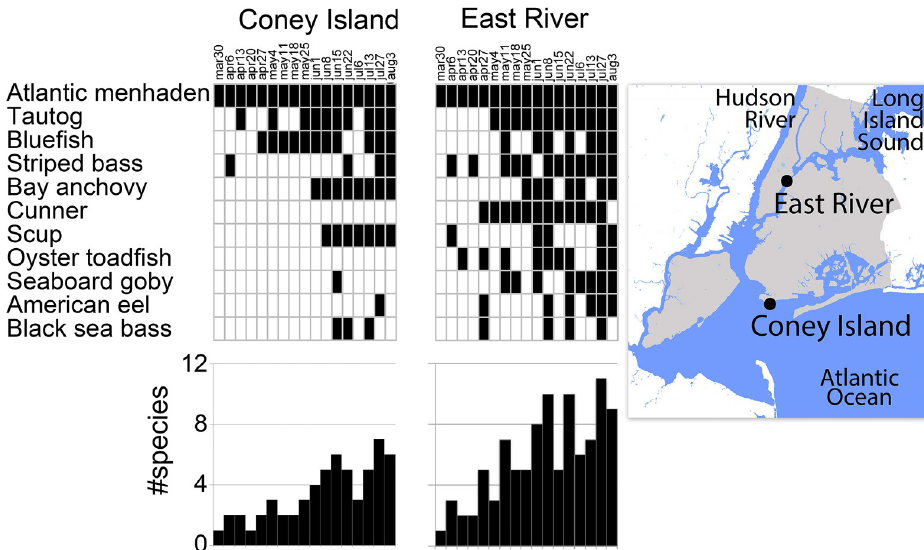
species arranged by decreasing number of positives; at bottom, number of species detected on each date is shown.